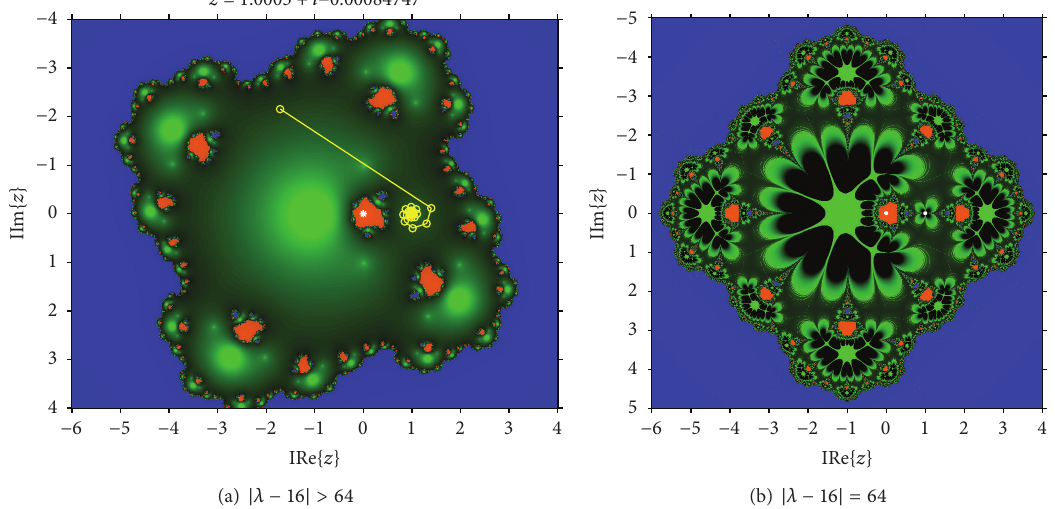
Figure 2: Dynamical planes for 𝜆 verifying |𝜆 − 16| ≥ 64 .